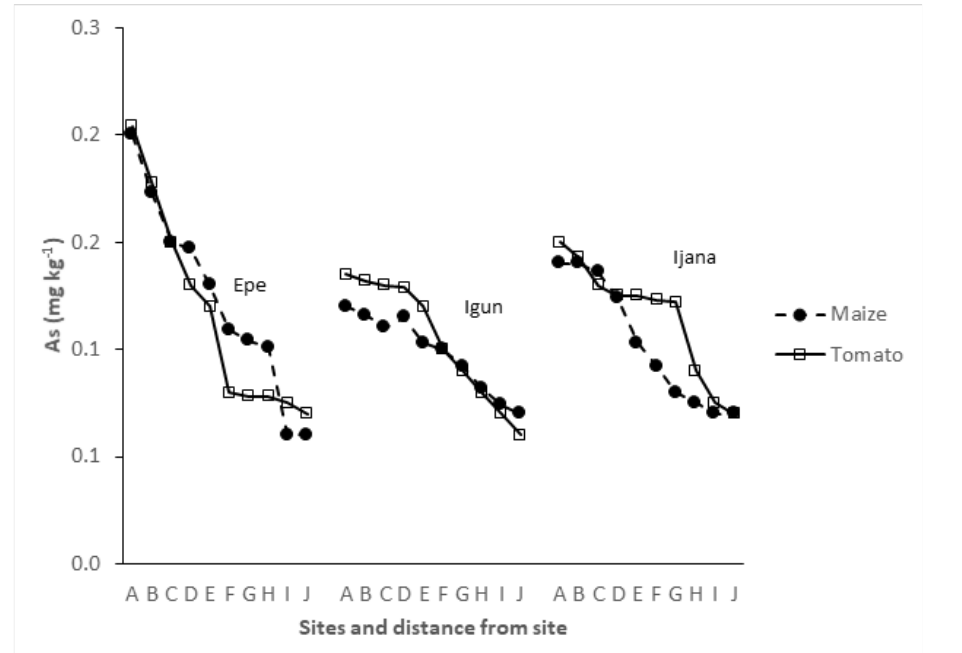
Figure 11: Concentrations of As in maize and tomato crops at Epe, Igun & Ijana (0 – 900 m) sites. A = 0 m from site; B = 100 m from site; C = 200 m from site; D = 300 m from site; E = 400 m from site; F = 500 m from site; G = 600 m from site; H = 700 m from site; I = 800 m from site; J = 900 m from